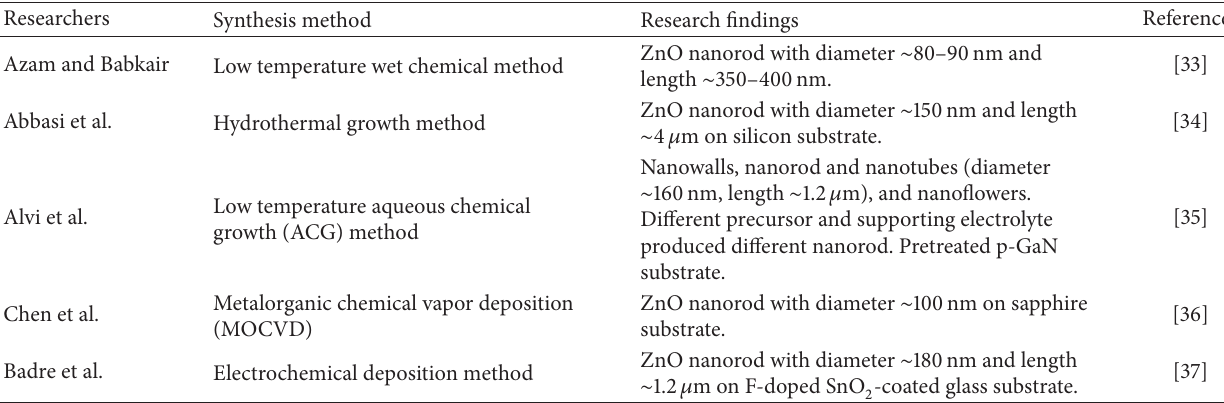
Table 1: The revolution of ZnO nanorod formation.